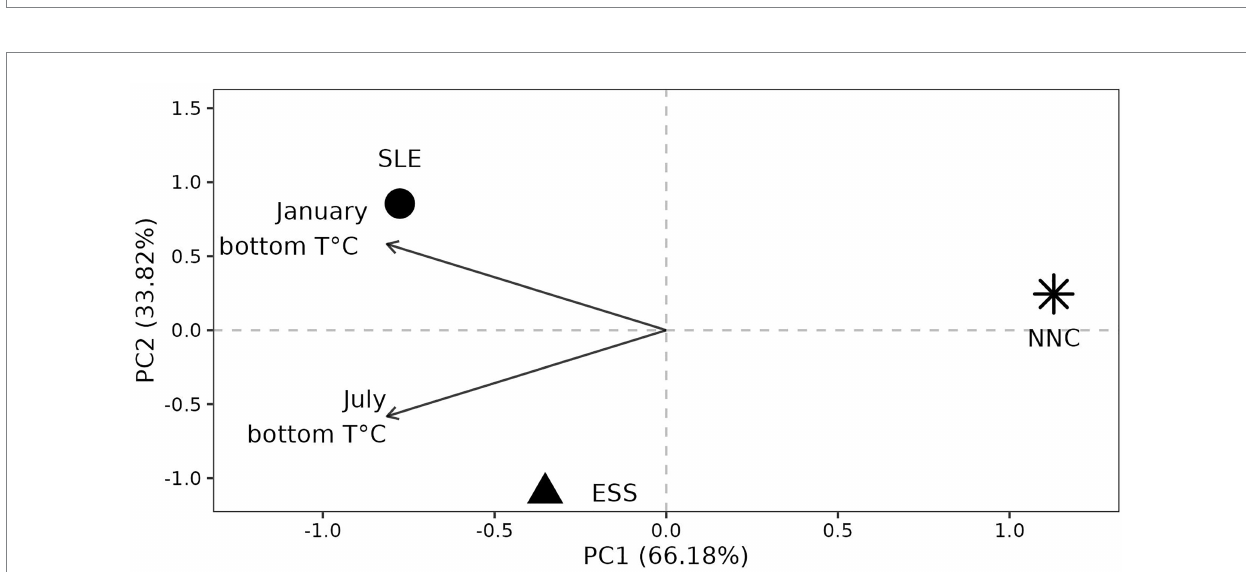
FIGURE 5 Environmental conditions at origin. Principal Component Analysis (PCA) using two monthly environmental variables that are not highly correlated (see methods for more details). ESS = Eastern Scotian Shelf, SLE = St. Lawrence Estuary, NNC = Northeast Newfoundland Coast, PC = Principal